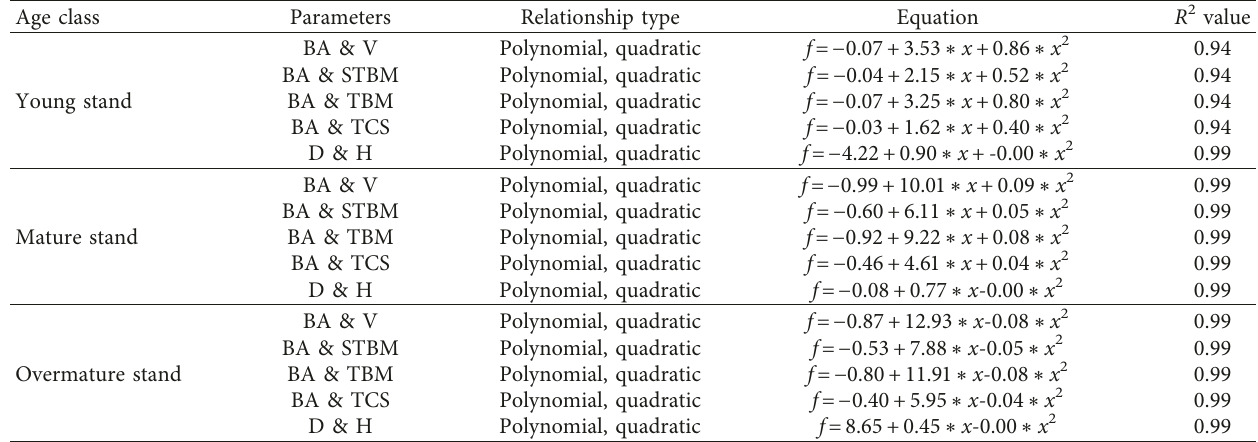
Table 3: Relationship type, equation, and R 2 value of the Pinus roxburghii stands.